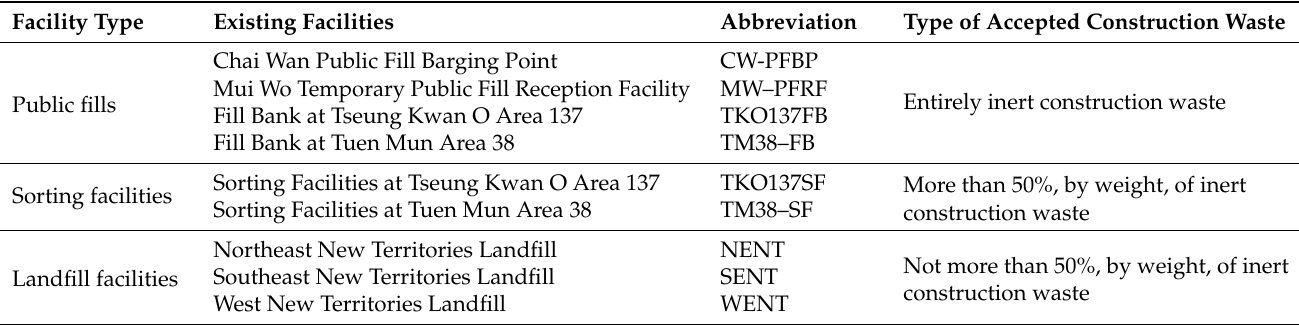
Table 2. Government construction waste disposal facilities.